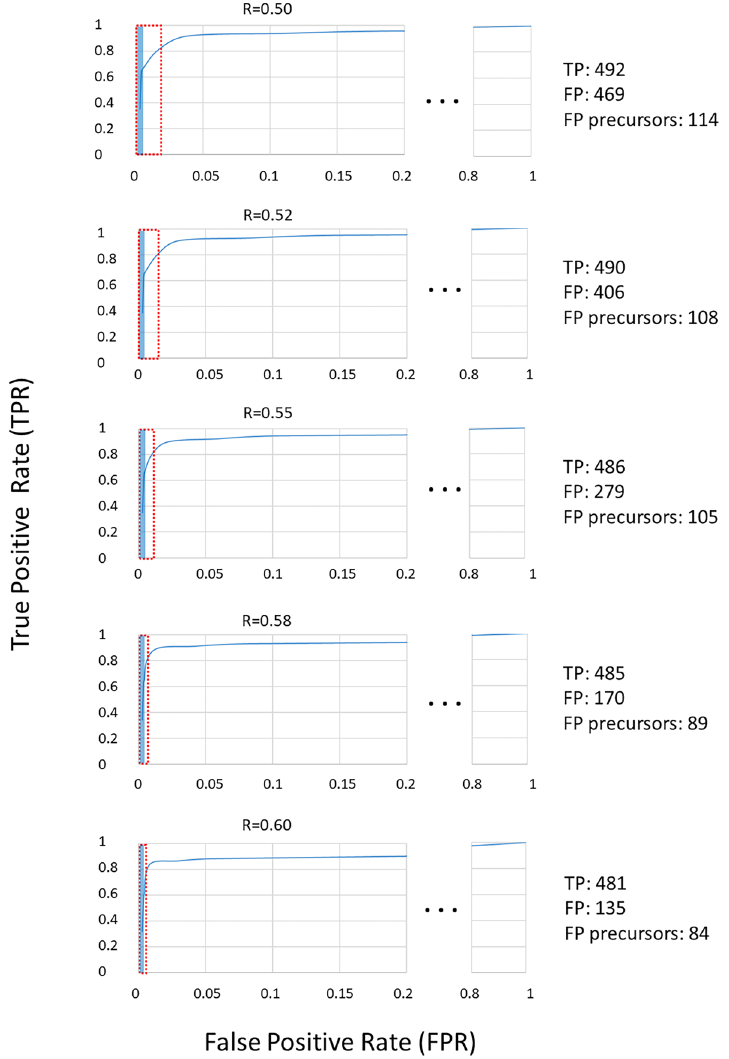
Figure 5. Receiver Operation Characteristic (ROC) curves for various threshold values of the R saturation. The number of True Positives (TP) and False Positives (FP) refers to a warning with at least four stations. The red and blue rectangles mark the range of FP for each threshold and the part of FP that comes as a precursor, respectively (the corresponding values are shown on the right side of the figure).